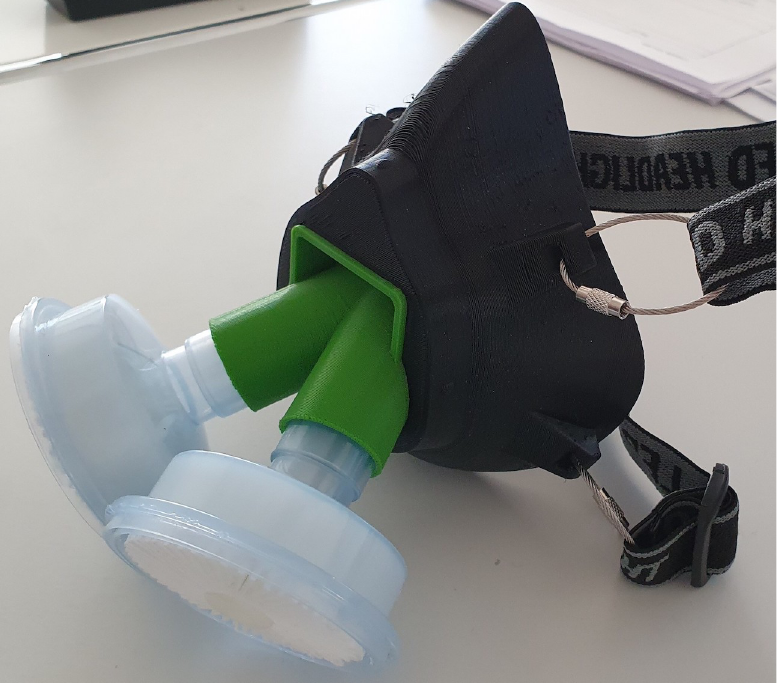
Fig 5. 3D-printed mask. 3D-printed mask from TPE with a printed PLA adapter and two attached